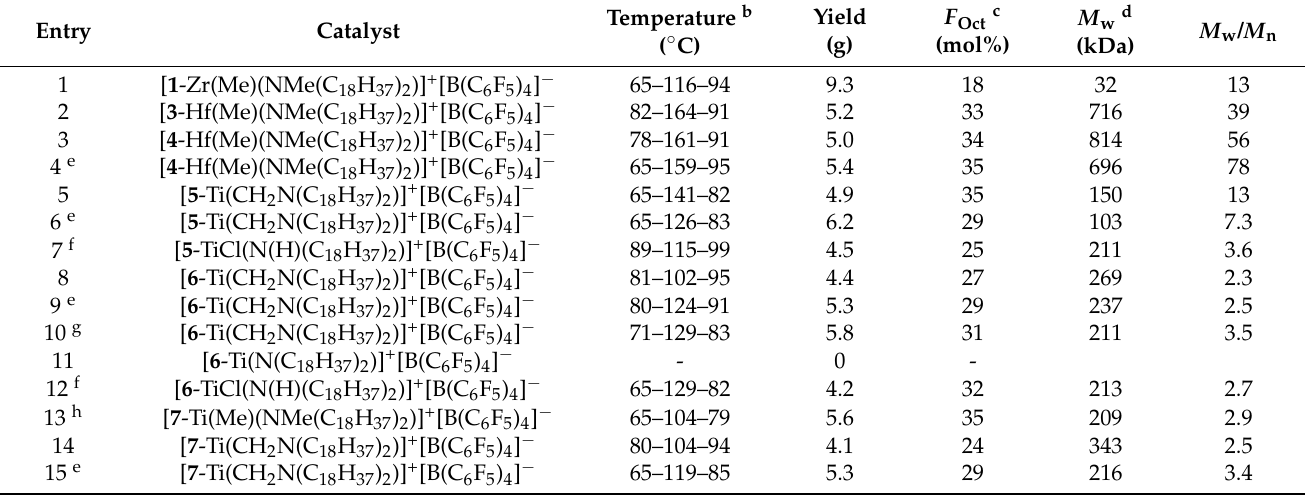
Table 1. Polymerization results a